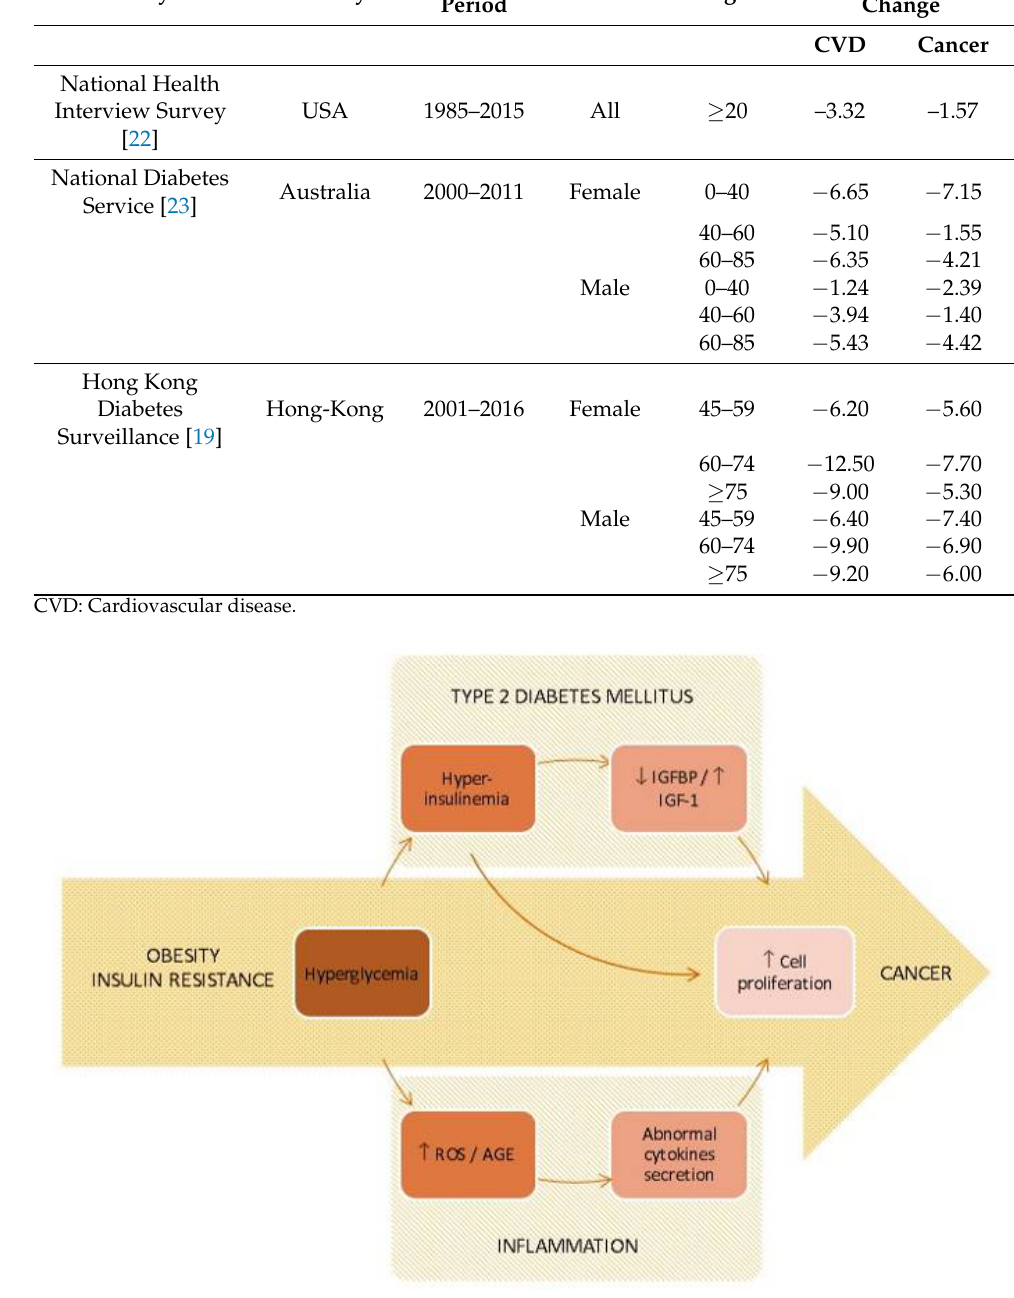
Figure 1. Pathophysiological links between obesity/insulin resistance, type 2 diabetes mellitus, inflammation and cancer. Adapted from Cignarelli et al. [24].